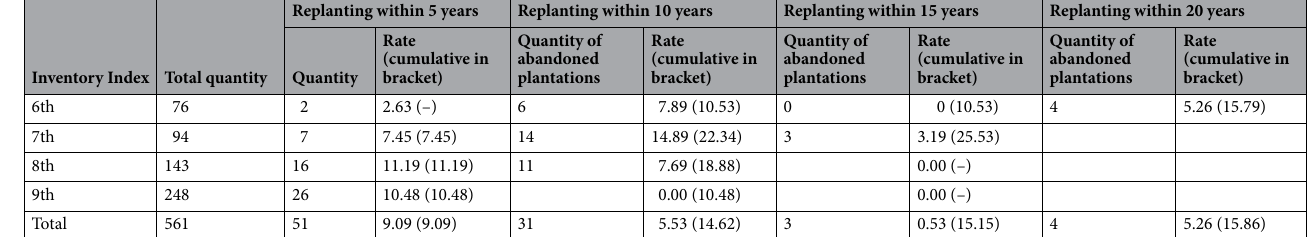
Table 10. Replanting rate of eucalyptus plantations.